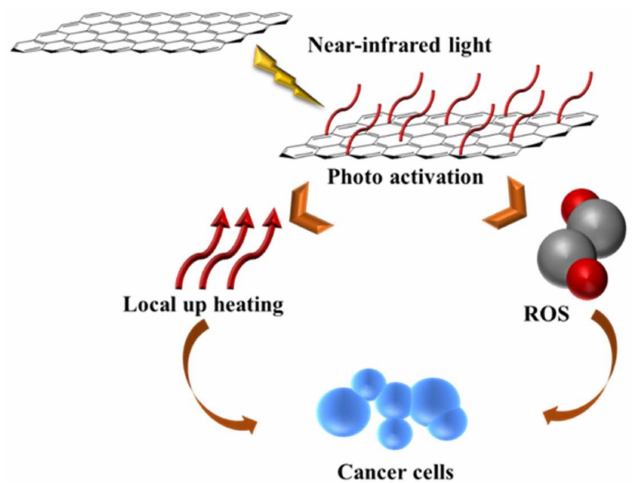
Figure 4. General representation of photothermal therapy by G derivatives. Adapted with permission from [198] copyright Elsevier